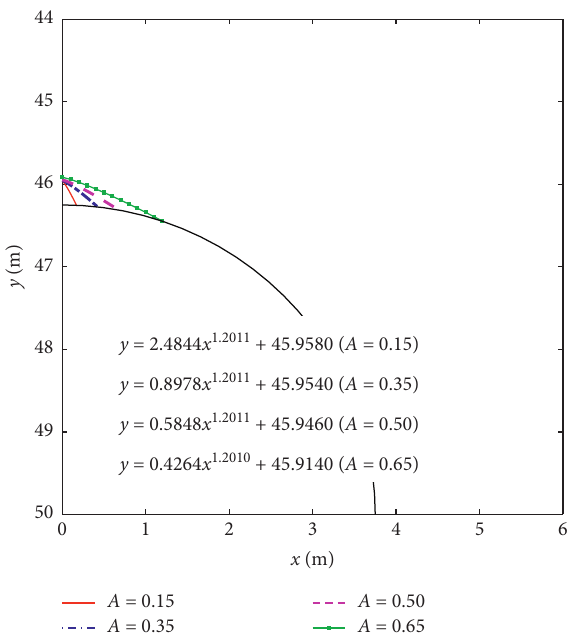
Figure 5: Effect of material parameter A of Hoek–Brown criterion on collapse mechanisms. The